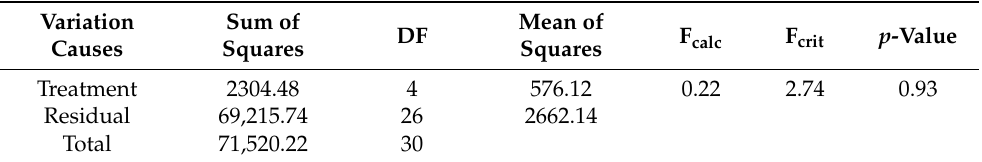
Table 4. ANOVA of (cid:1831) (cid:3028)(cid:3029)(cid:3046) in the stand-alone ballistic test of fique fabric reinforced epoxy Table 4. ANOVA of E abs in the stand-alone ballistic test of fique fabric reinforced epoxy composites composites and plain epoxy. and plain epoxy.